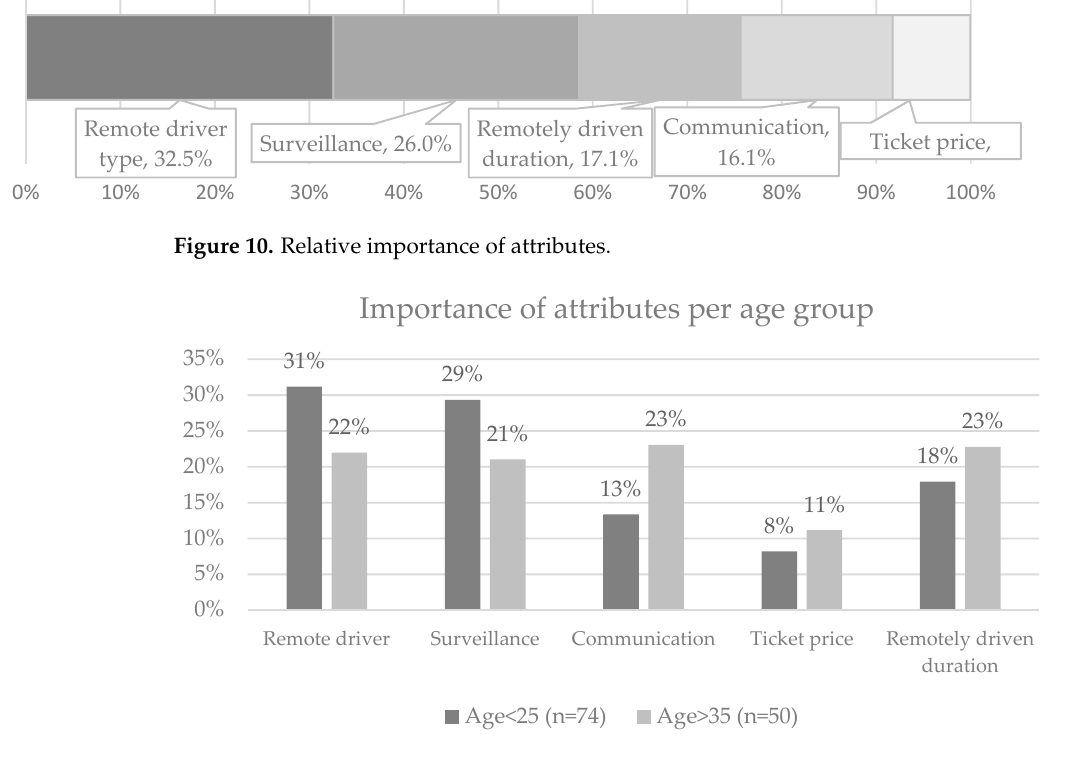
Figure 11. Relative importance of attributes for younger and older groups.